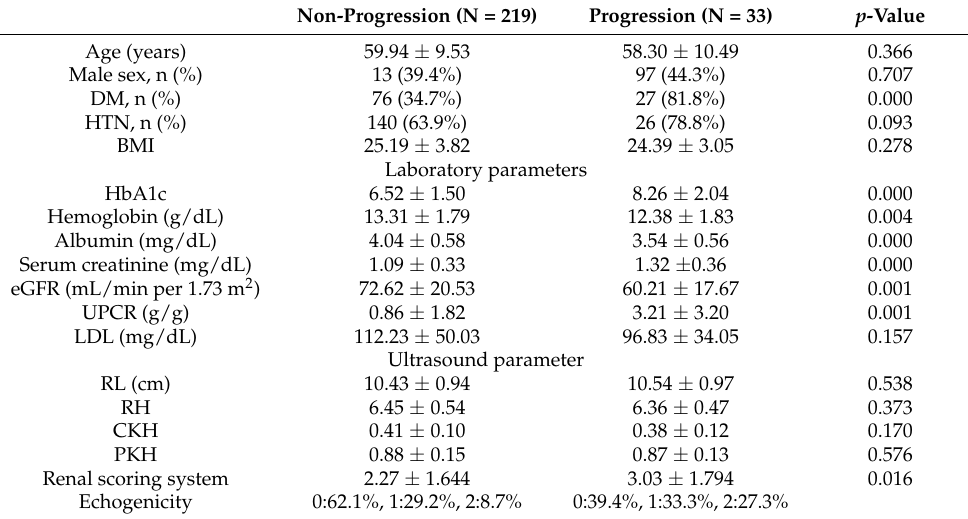
Table 4. Comparison of clinical and ultrasound findings between progression and non-progression